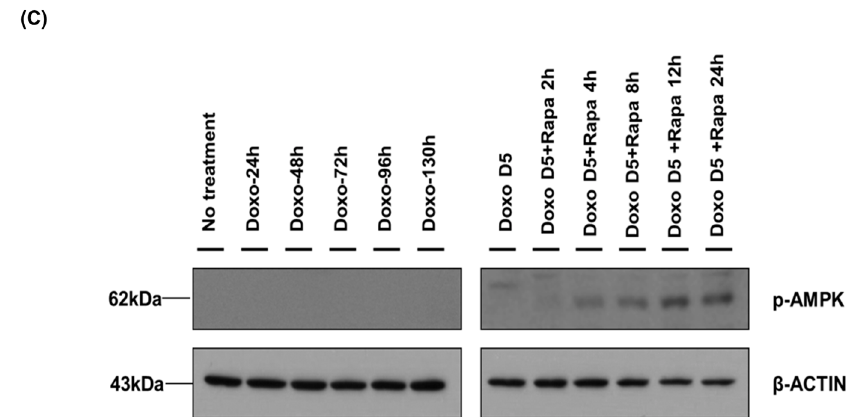
Figure 3. mTOR expression in doxorubicin-treated hCPCs. ( A ) mTOR expression by Western blot afterDOXO treatment for 24, 48 and 72 h. mTOR expression in hCPCs increased significantly in a time-dependent manner after treatment with DOXO. hCPCs at Passage 14 were used as senescence cells; ( B ) mTOR expression was quantified and normalized as per control. ** p < 0.01 versus control. Sen: Senescence hCPC; mTOR: mammalian target of rapamycin; ( C ) Increased AMPK phosphorylation in response to rapamycin-treated CPCs (at 100 nM DOXO for 5 days).